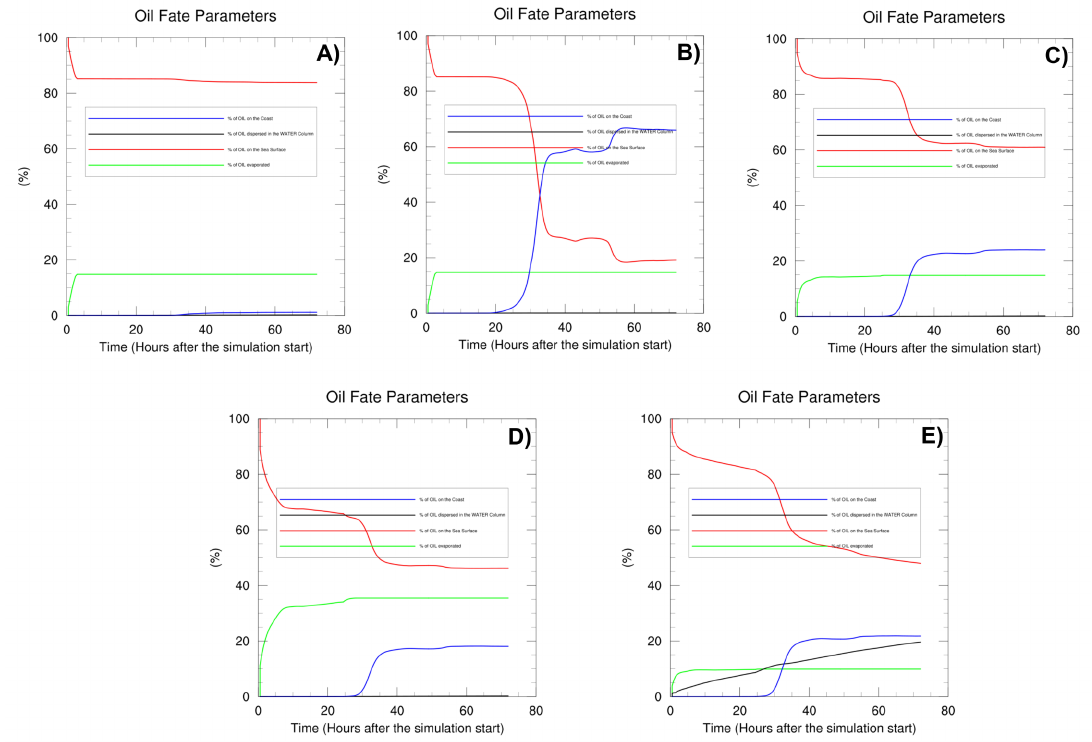
Figure 5. Temporal evolution (%) of the oil fate parameters during the 4 experiments from ( A – E ) characterized as in Table 1: the green line is the the evaporation, the red on is the oil on the sea surface, the blue one is the beaching, and the black one is the oil dispersed in the